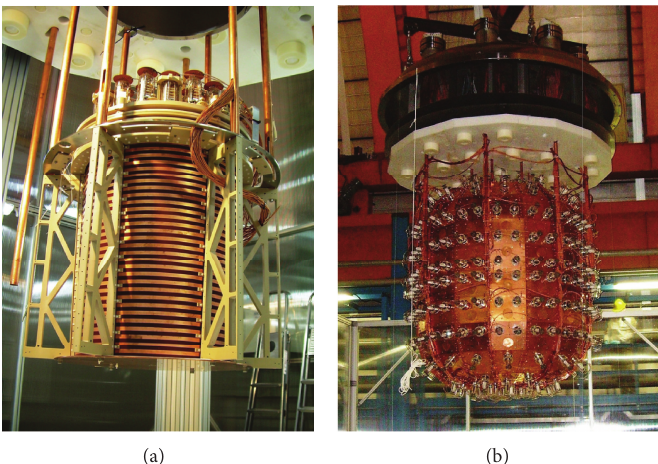
Figure 5: (a) Picture of the inner detector, completed in the clean room. (b) Completed WArP 100l detector, ready to be inserted in its cryostat. The veto is visible, hanging from the cryostat top flange; the inner detector is